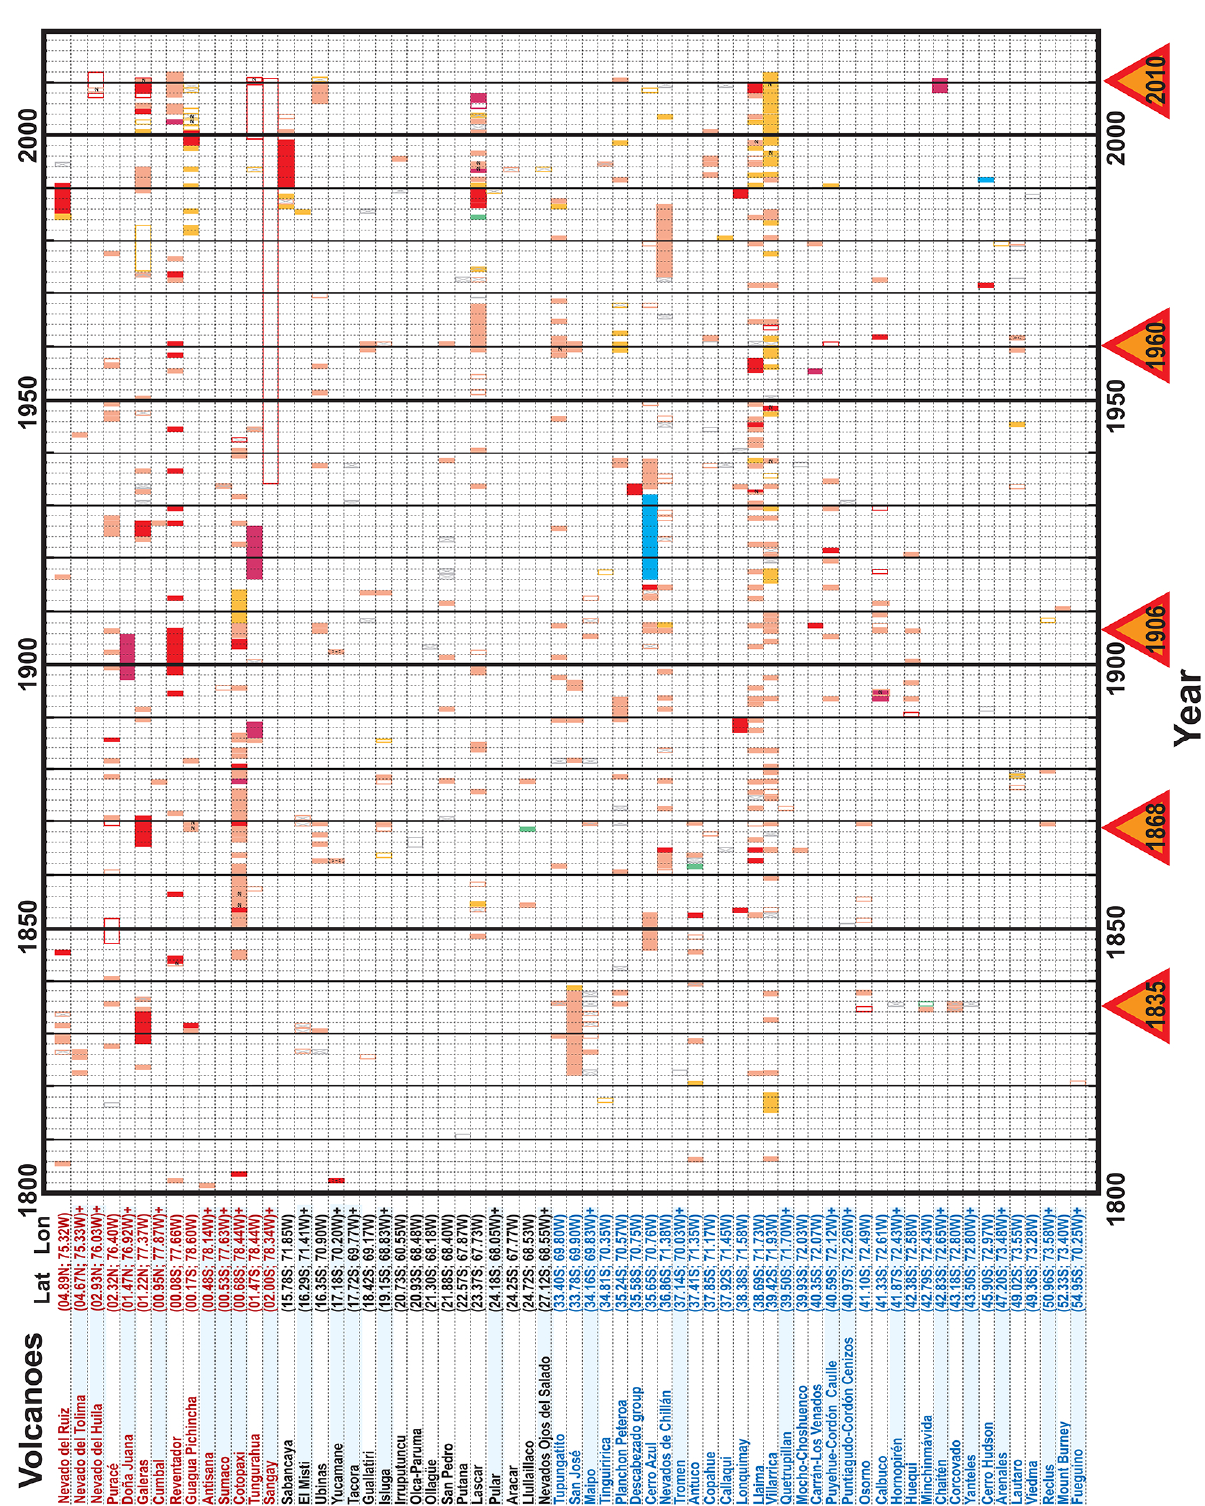
Fig. 1a. The complete catalogue of eruption data for the Andean belt from 1800 to 2010. The data was collected by the Smithsonian Institution (Siebert et al., 2011). Light blue bands mark the new entries in the volcanoes list compared to the data used in analysis a few years ago (Scalera, 2008). On the time axis 1800–2010 the eruptions are represented by rectangular bars, horizontal length of which is equal to the duration of the eruption and following the Volcanic Explosivity Index (VEI) colour scale on the right. The coloured names of the volcanoes are subdivided according to the three volcanic districts (northern-red, central-black, southern-blue). Counting the eruptions by years or triennium a graph like the following Fig. 2 can be